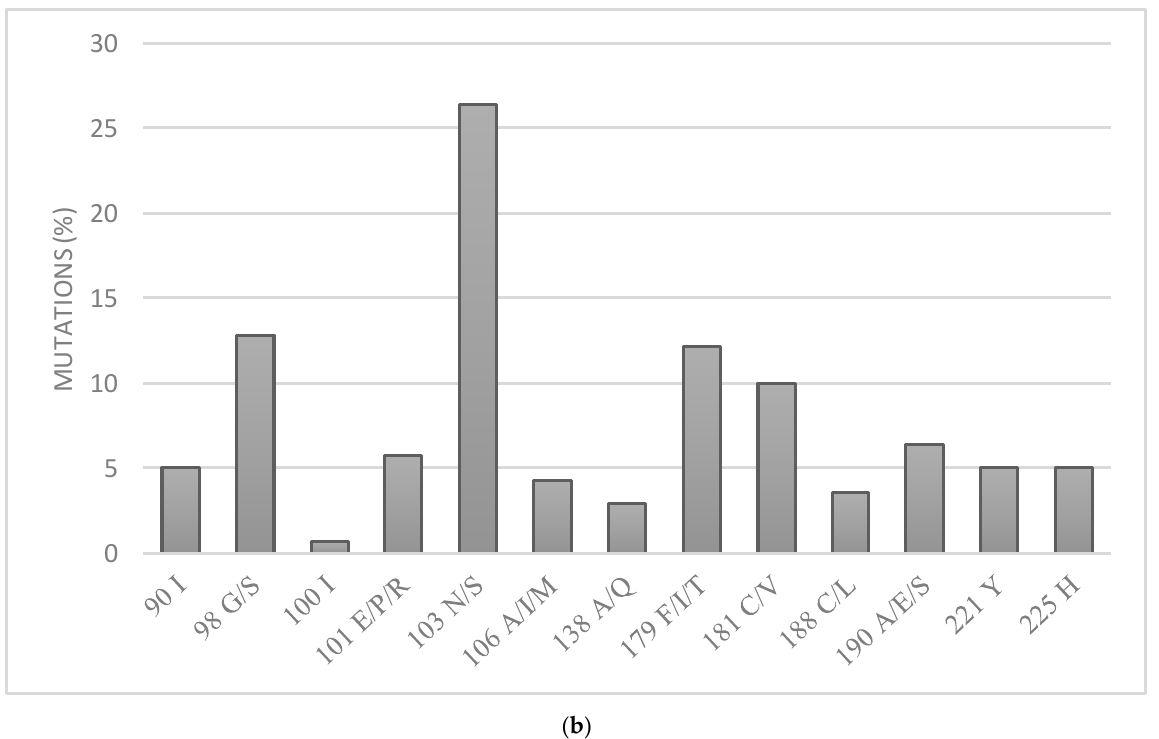
Figure 3. Observed frequency of mutations conferring resistance to ( a ) nucleoside reverse transcriptase inhibitors (NRTIs) and ( b ) non-nucleotide reverse transcriptase inhibitors (NNRTIs).